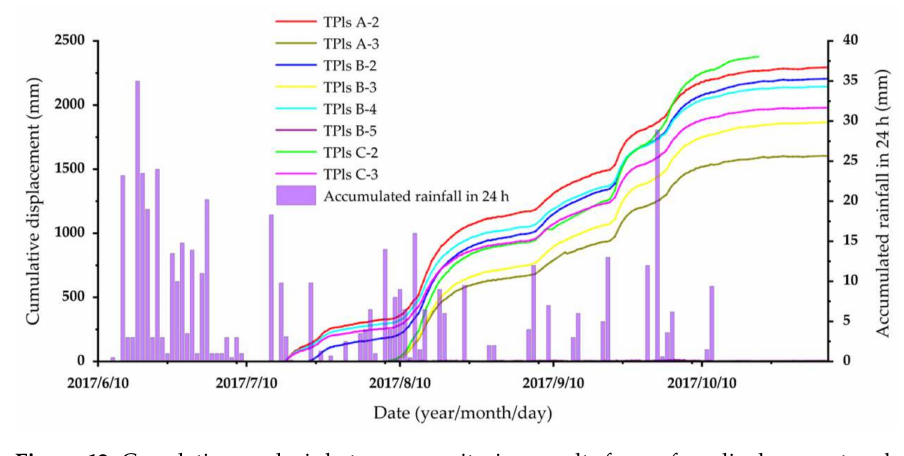
Figure 12. Correlation analysis between monitoring results for surface displacement and rainfall.